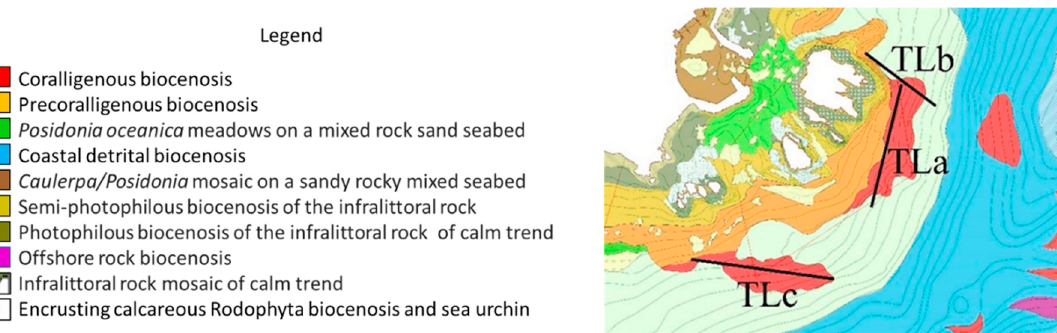
Figure 2. Detail of the three ROV transects. The legend shows the principle biocenosis present in the study area.